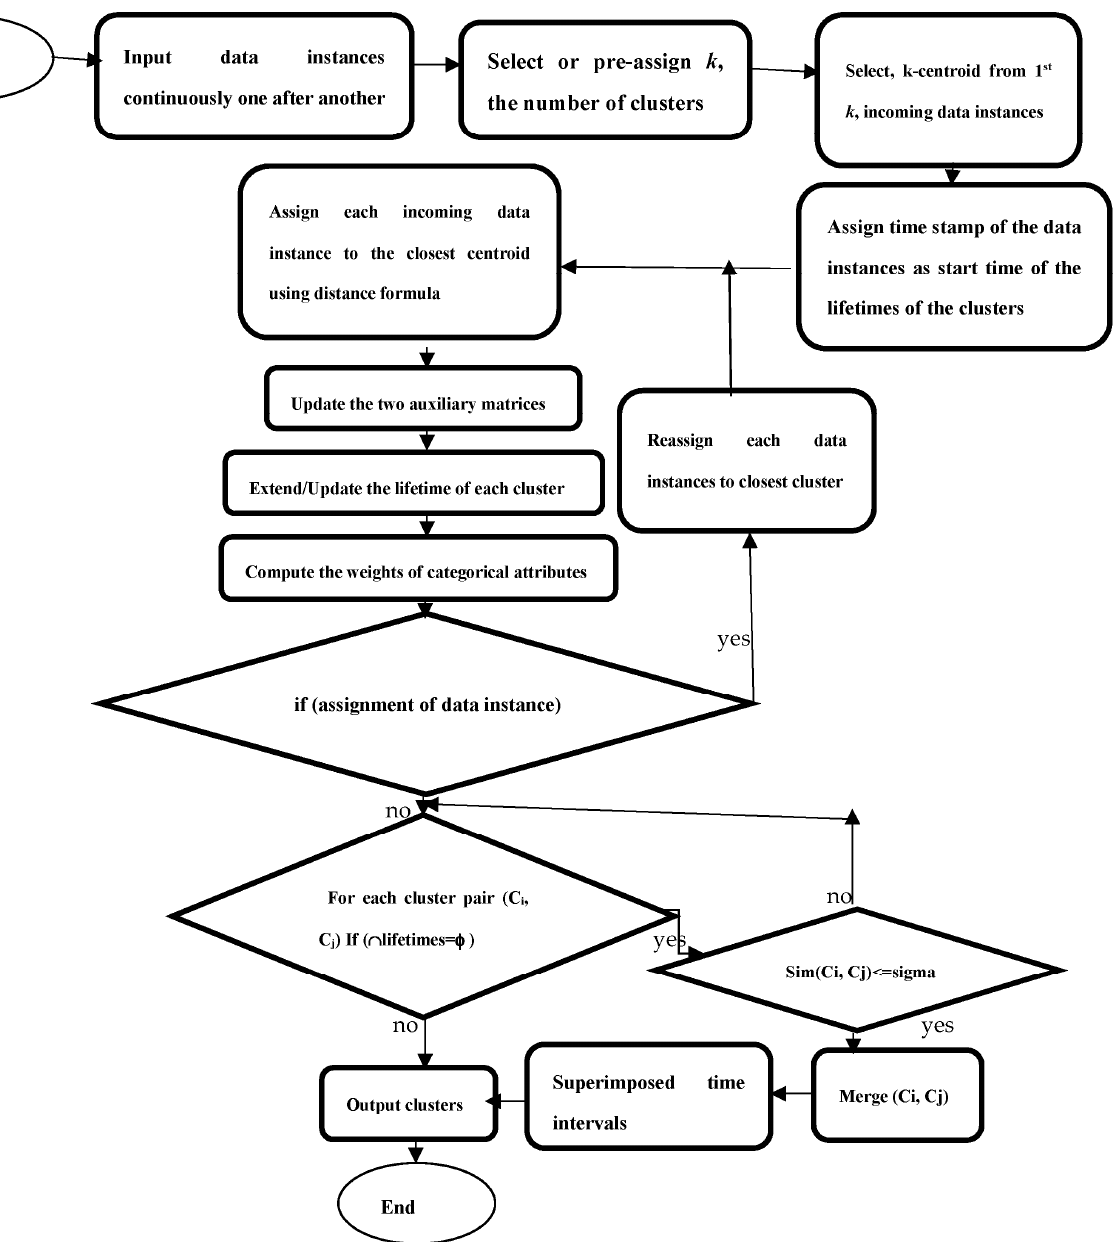
Figure 1. Flowchart of the proposed algorithm.